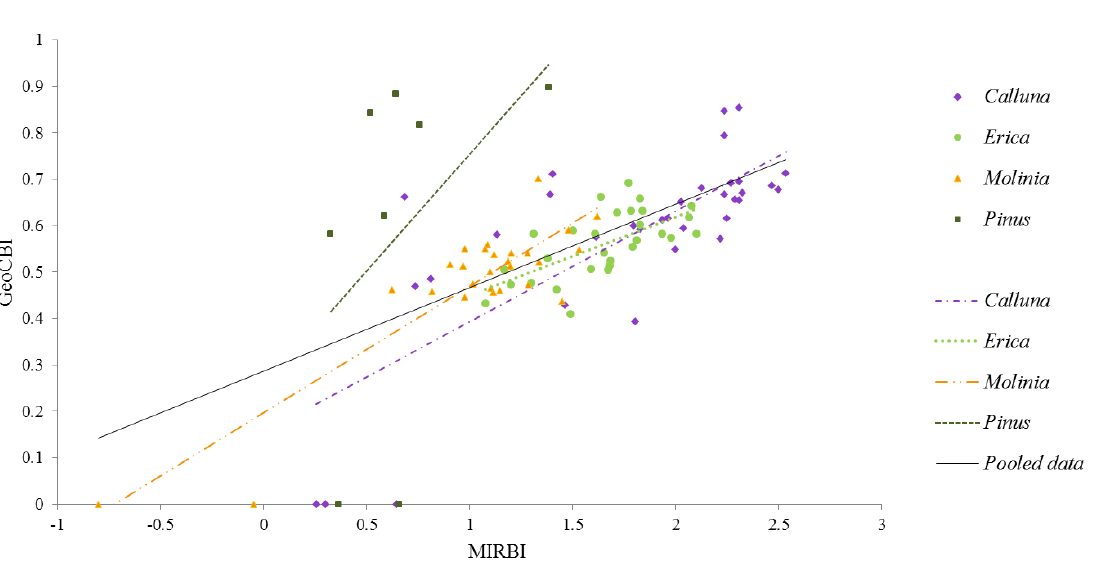
Figure 4. Scatter plots and linear regression lines between the Mid-Infrared Burn Index (MIRBI) and the Geometrically structured Composite Burn Index (GeoCBI) field data, for pooled data and for separate data per vegetation